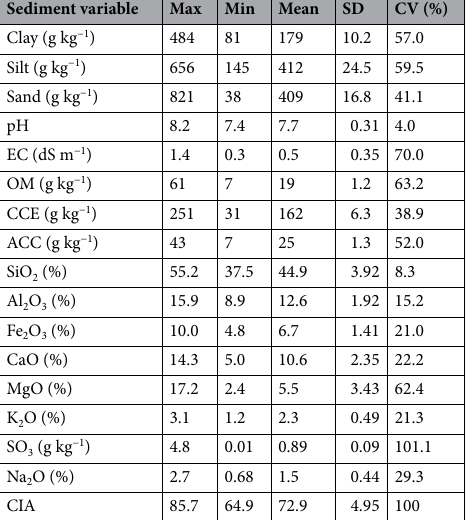
Table 2. Summary statistics of sediment properties. OC organic matter; CCE calcium carbonate equivalent; ACC active calcium carbonate; CEC cation exchange capacity; EC electrical conductivity; SAR sodium adsorption